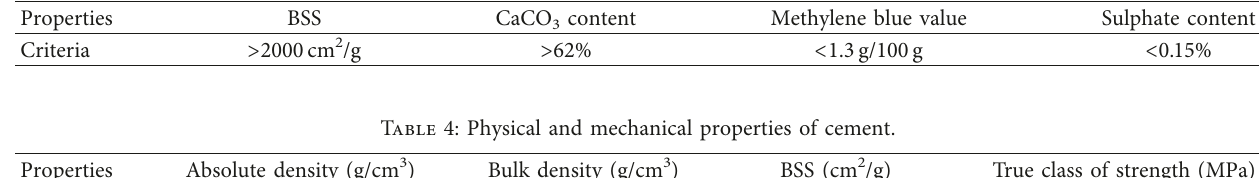
Table 3: Physical and chemical properties of fillers according to Benjeddou et al. [2].